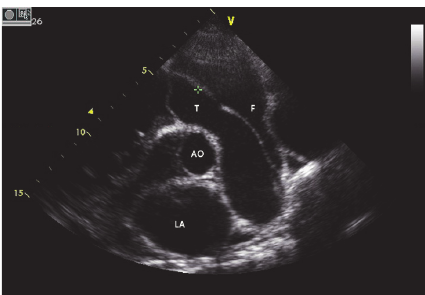
Figure 2: Echocardiogram. Two-dimensional transthoracic echo- cardiography in short-axis view of the heart base showing a greatly dilated pulmonary trunk with the dissection membrane (+). AO, aorta; LA, left atrium; T, true lumen; F, false